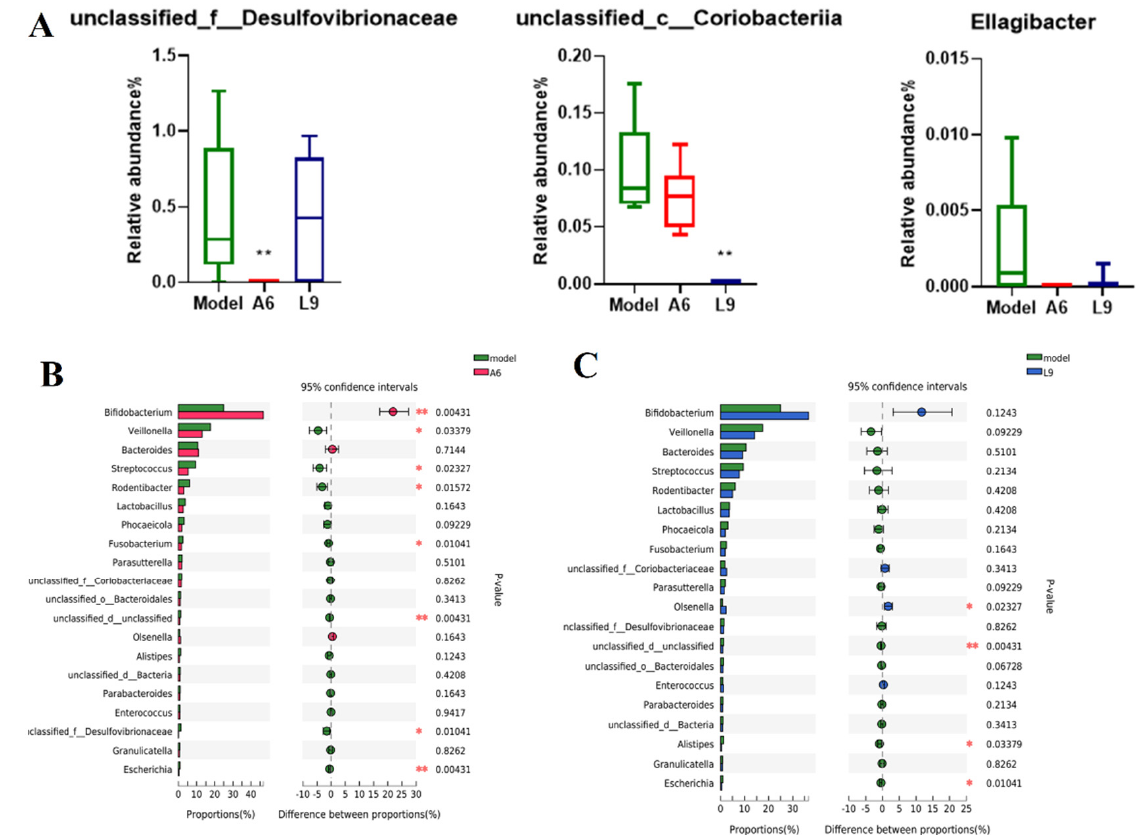
Figure 6. Effects of A6 and L9 administration on abundance changes in characteristic taxa at the genus level. ( A ) Characteristic taxa derived from LEfSe analysis. ( B ) Difference comparisons of species abundances between A6 and model groups using the Wilcoxon-Mann-Whitney U test. ( C ) Difference comparisons of species abundances between L9 and model groups using Wilcoxon rank-sum/Mann-Whitney U test (* p < 0.05, ** p < 0.01).